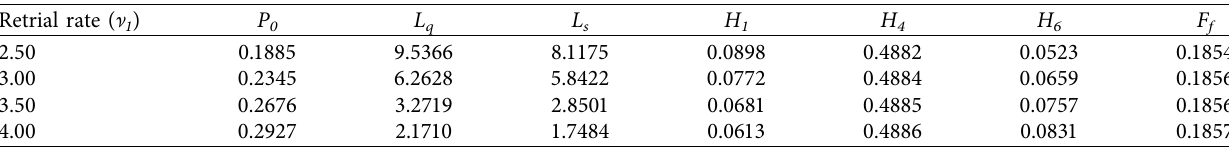
; ] , λ , ] , ] , θ 1 , α 0 . 4 , ] 7 4 . 2 (cid:31) 1 4 (cid:31) 4 1 (cid:31) 3 6 (cid:31) 2 (cid:31) (cid:31) (cid:31)